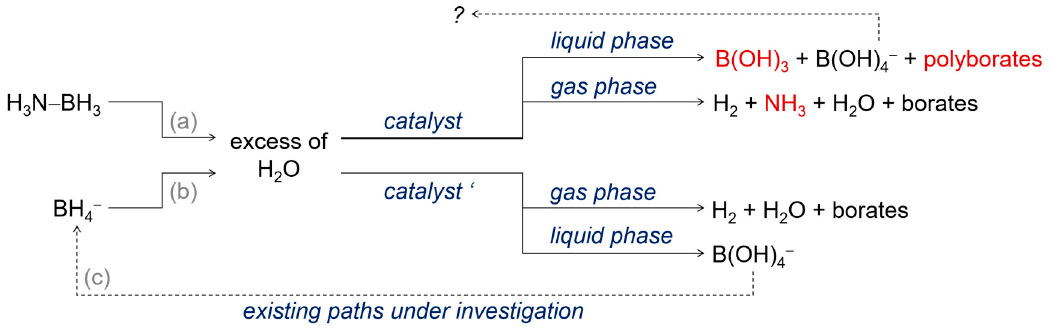
Figure 3. ( a ) Hydrolysis of ammonia borane. ( b ) Hydrolysis of sodium borohydride. ( c ) Recycling of the sodium borohydride hydrolysis product. In red are shown the main differences between path ( a ) and path ( b ), thereby making the latter superior.